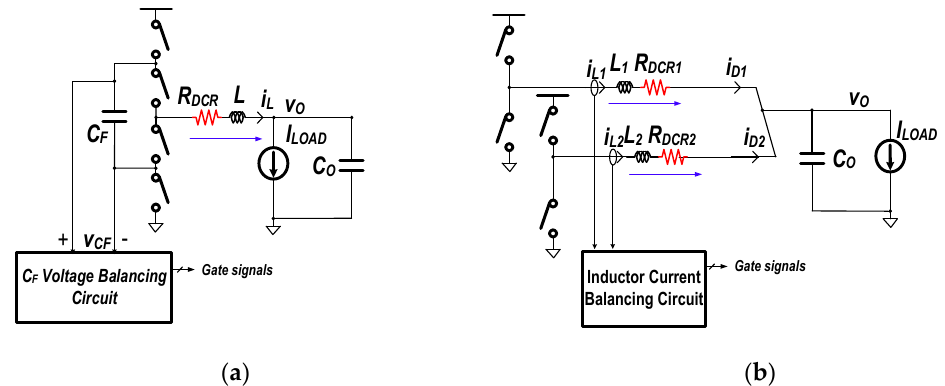
Figure 3. Alternative topologies for reducing conduction loss in R DCR : ( a ) multi-level buck converter; ( b ) multi-phase buck converter.